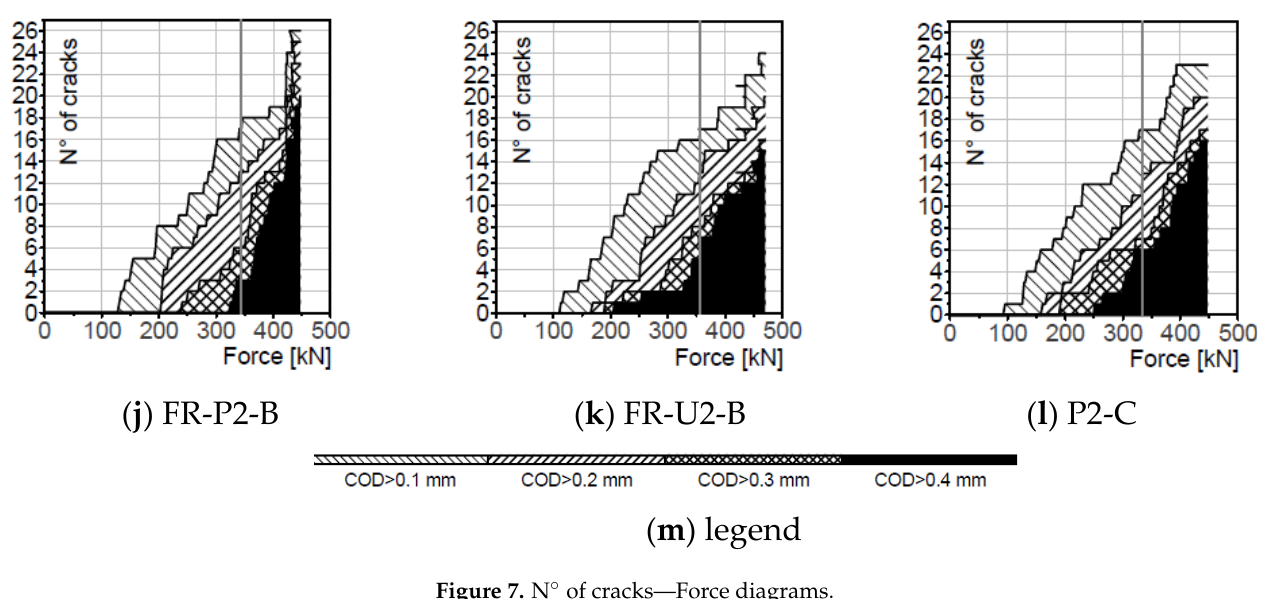
Figure 7. N° of cracks—Force diagrams. Figure 7. N ◦ of cracks—Force